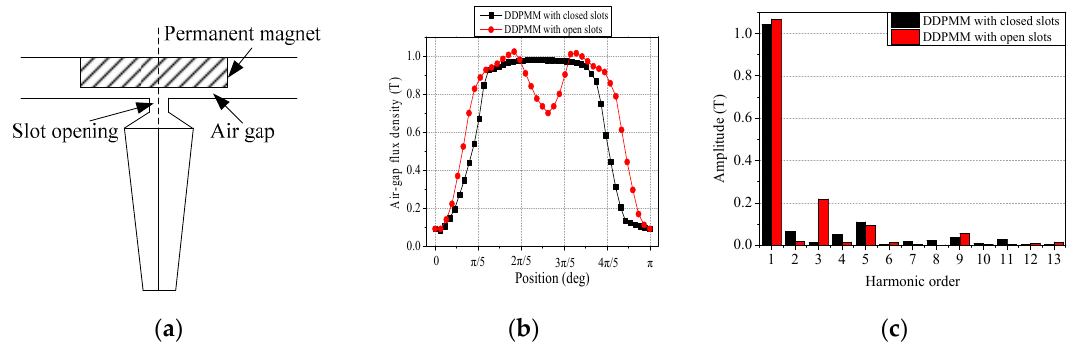
Figure 5. Magnetic field analysis at position 1: ( a ) position 1; ( b ) air-gap flux density waveforms; ( c )